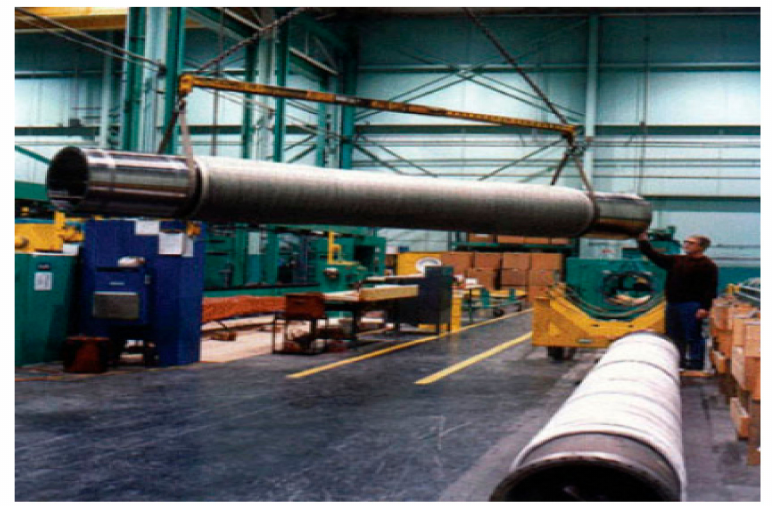
Figure 19. Composite riser pressure test samples (Courtesy of Lincoln Composites).